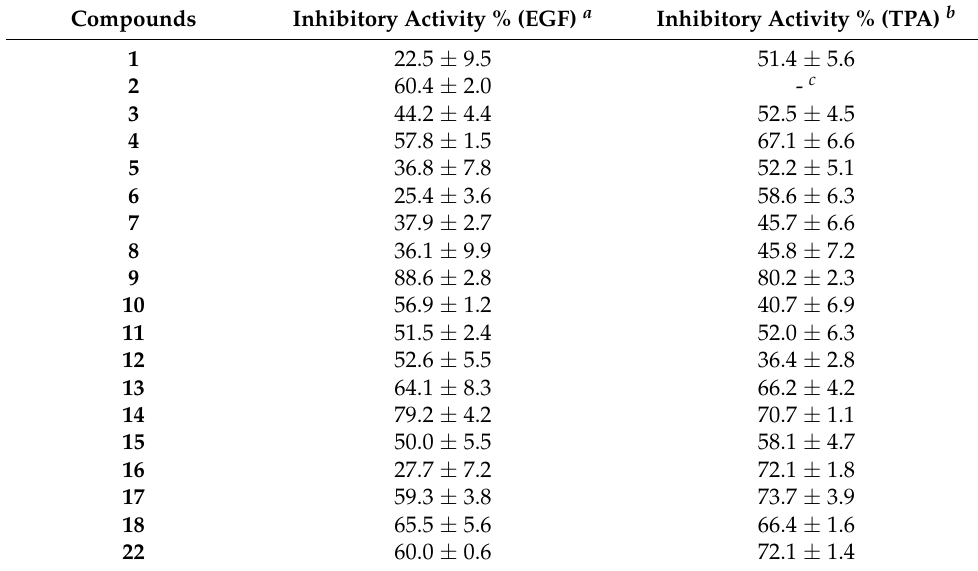
Table 3. Inhibitory activities of compounds on EGF- and TPA-induced cell